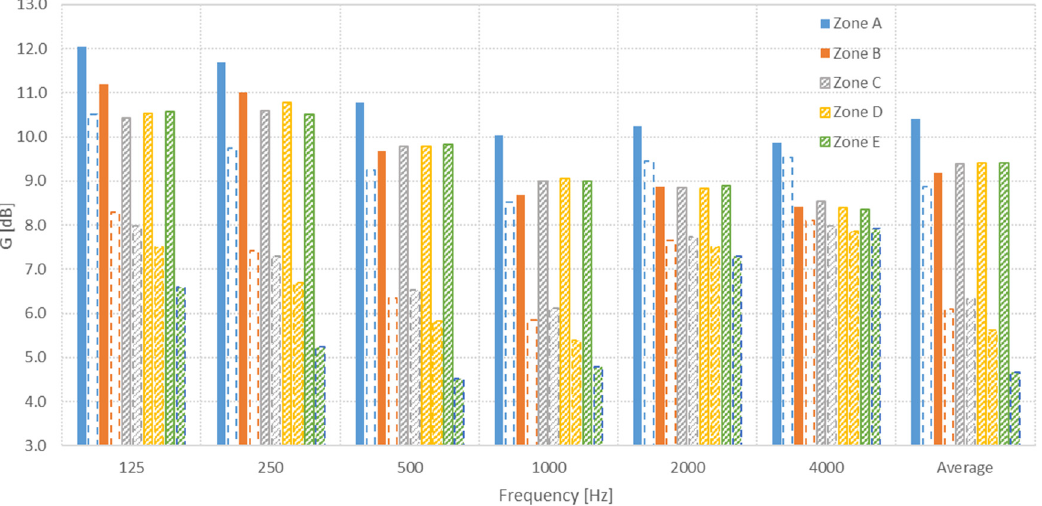
Figure 18. Strength parameter (G) obtained in the auditorium, when variable acoustic solution provides maximum reflection (solid columns—configuration R) and when the variable acoustic solution provides maximum absorption (dashed columns—configuration A) by zones.